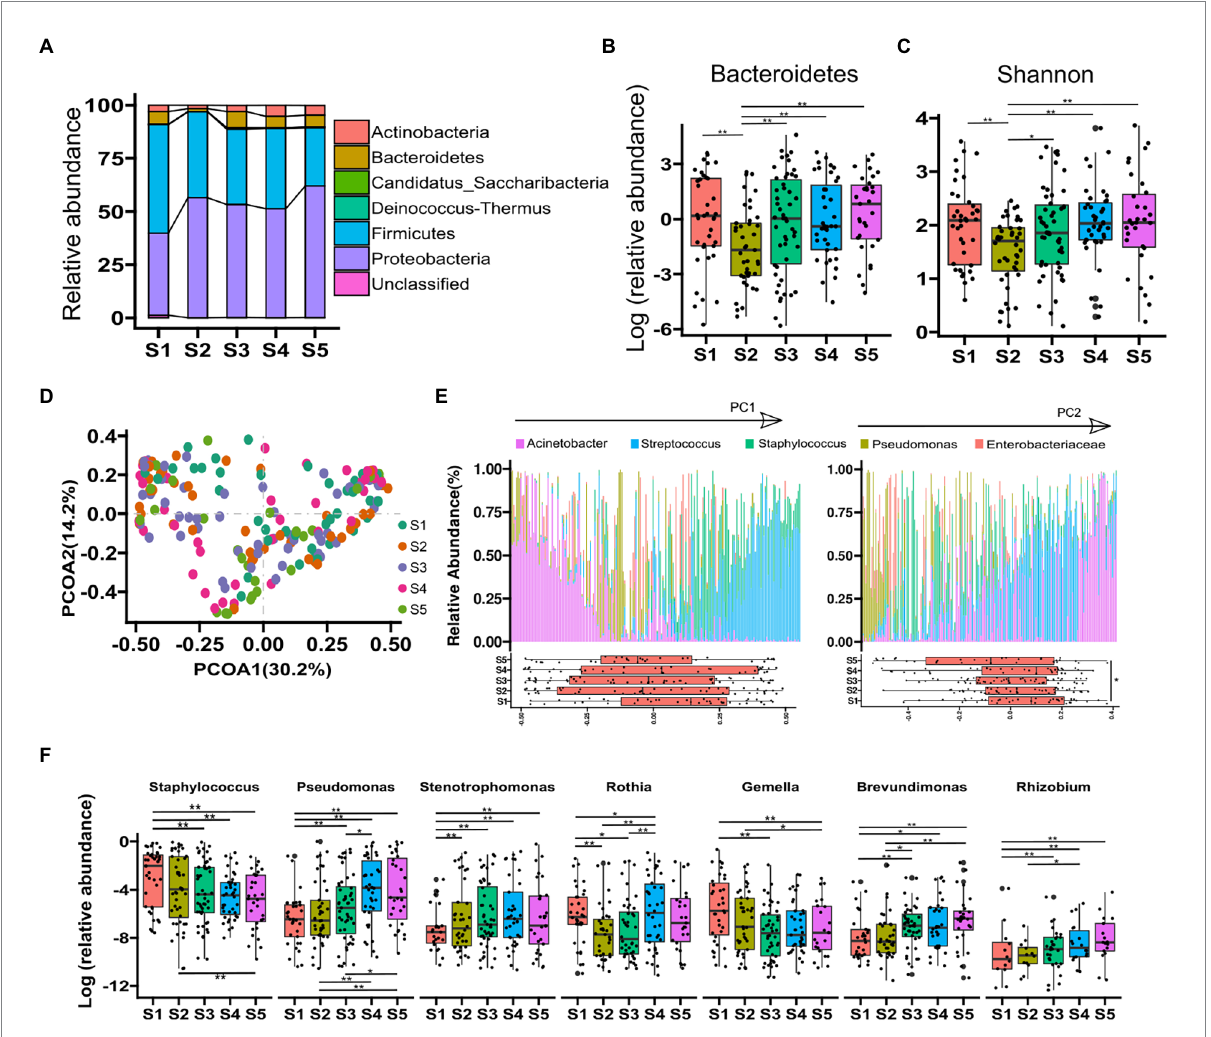
FIGURE 1 Microbiota diversity and composition varied by lactation phase. (A) , the relative abundance of phyla in each phase. (B) , statistical analysis of Bacteroidetes from each phase. (C) , difference of Shannon index of samples from all phases. (D) , principal coordinates analysis (PCoA) using relative abundance data at genus level. (E) , five predominant genera in the 203 breast milk samples. The most abundant bacterial genera are indicated by arrows and genus names. Two principal components (PC1 and PC2) were showed. Boxplots showed the variance of microbial abundance at each stage. (F) , boxplot of the top 7 species from all phases and MetaStat by permutation test [ p value was the adjusted result of Benjamini and Hochberg False Discovery Rate (BH FDR)]. * p < 0.05, ** p <